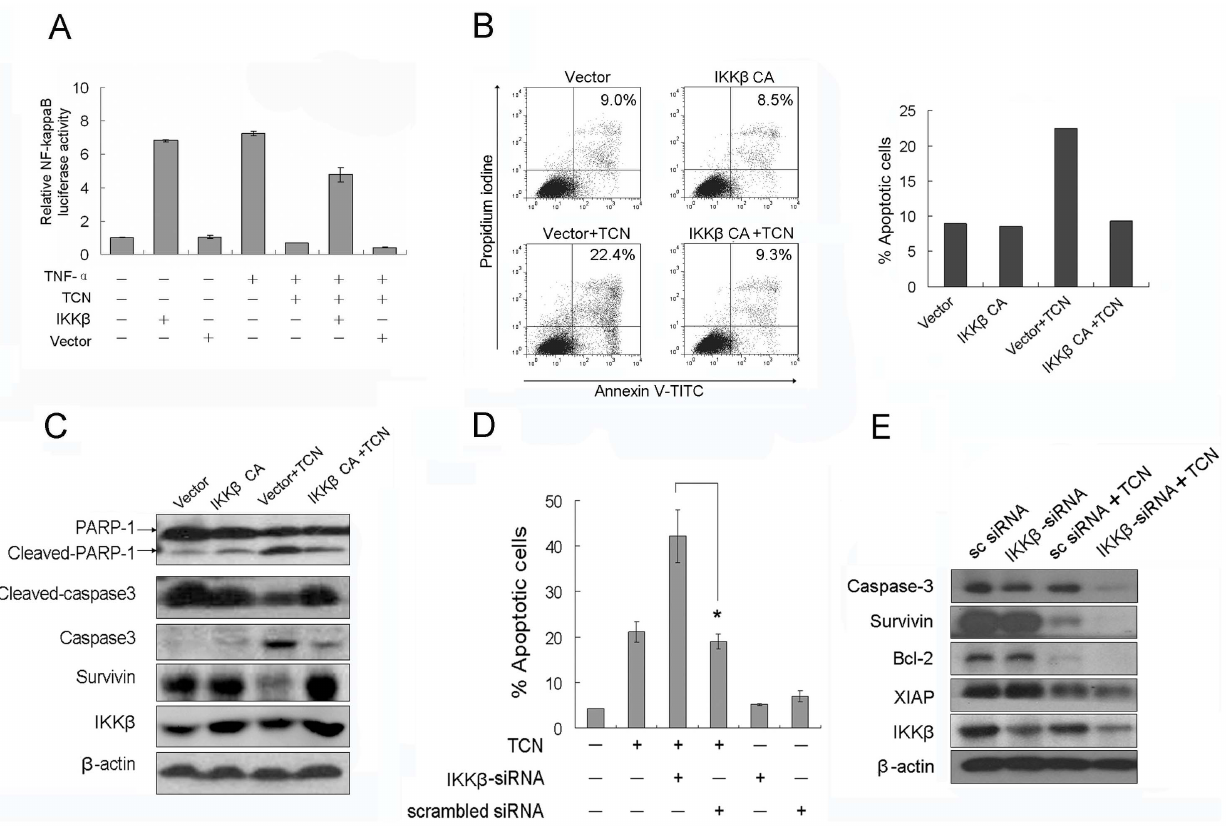
Figure 5. TCN induced cancer cell apoptosis is mediated by inhibition of IKK b phosphorylation. (A) HEK 293T cells were transiently transfected with IKK b CA or empty vector for 12 h, then pretreated with 2.5 m M TCN and stimulated with 25 ng/mL TNF- a for 18 h. Cells subjected to analysis of luciferase activity. (B) HepG2 cells were transiently transfected with IKK b CA or empty vector for 12 h, and then treated with 2.5 m M TCN for 24 h. Cells subjected to apoptosis analysis. (C) HepG2 cells were transfected with IKK b CA or empty vector for 12 h, and then treated with 2.5 m M TCN for 24 h. Cells subjected to western blot analysis for the expression of indicated proteins. (D) HepG2 cells were transiently transfected with a scrambled siRNA or IKK b -siRNA for 48 h, treated with 2.5 m M TCN for 24 h and subjected to apoptosis analysis. (E) HepG2 cells transiently transfected with scrambled siRNA or IKK b -siRNA were treated with 2.5 m M TCN for 24 h. Cell lysates were collected and subjected to western blot analysis with the specified antibodies. Experiments were done independently in triplicate and the results are reported as means and standard deviations. Statistical analysis was perform with Student’s t-test, *p , 0.05.